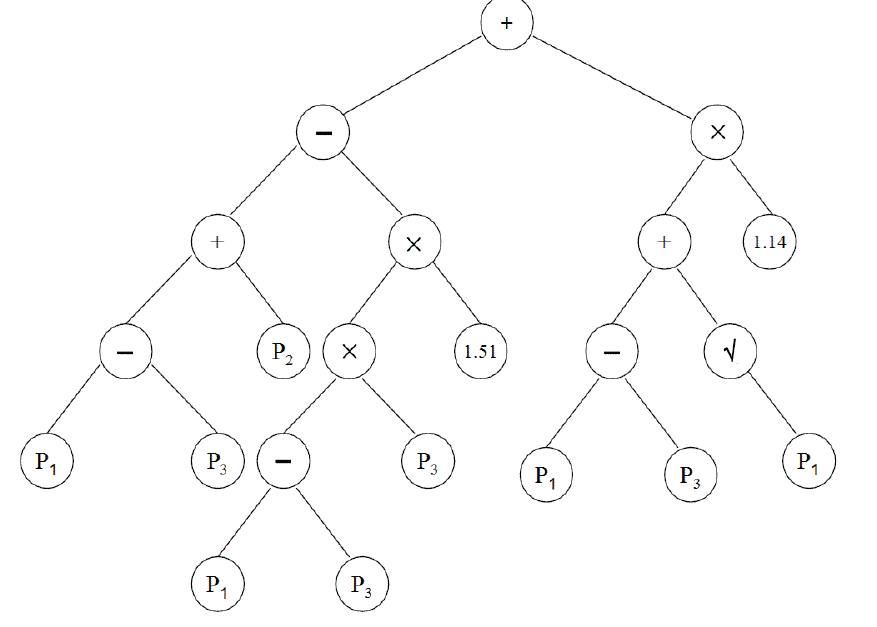
, P and P are given in Table 1 2 3